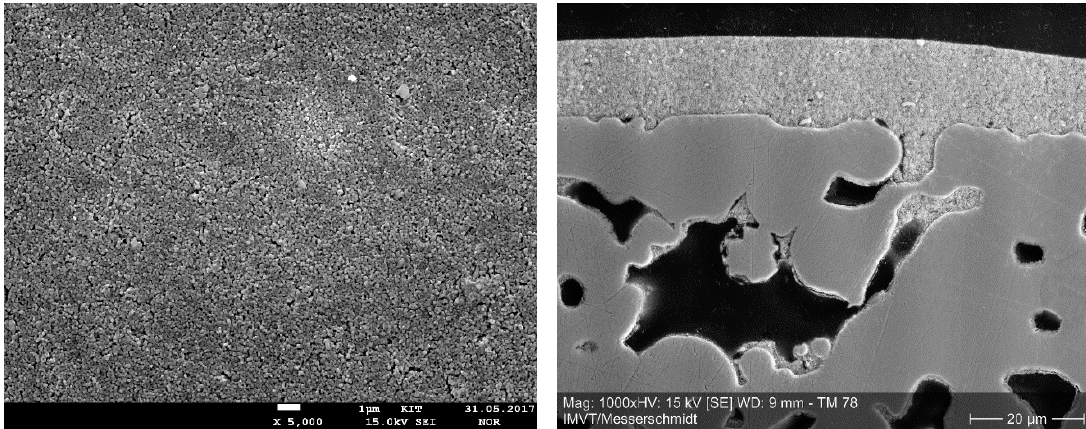
Figure 5. Surface ( left ) and cross-sectional view ( right ) of substrates currently fabricated at IEK-1 in Jülich and Institute for Micro Process Engineering (IMVT) in Karlsruhe.